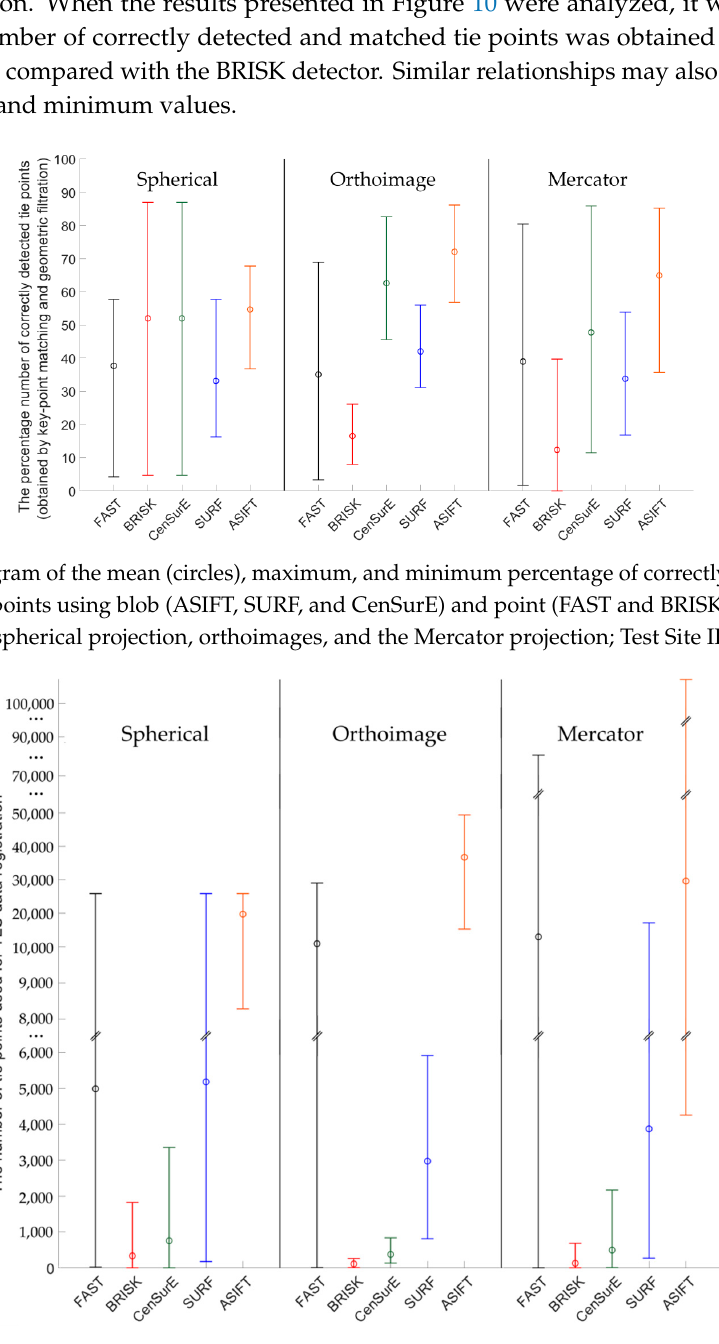
Figure 10. Diagram of the mean (circles), maximum and minimum number of correctly detected and matched key points using blob (ASIFT, SURF, and CenSurE) and point (FAST and BRISK) detectors for rasters in the spherical projection, orthoimages, and the Mercator projection; Test Site II.